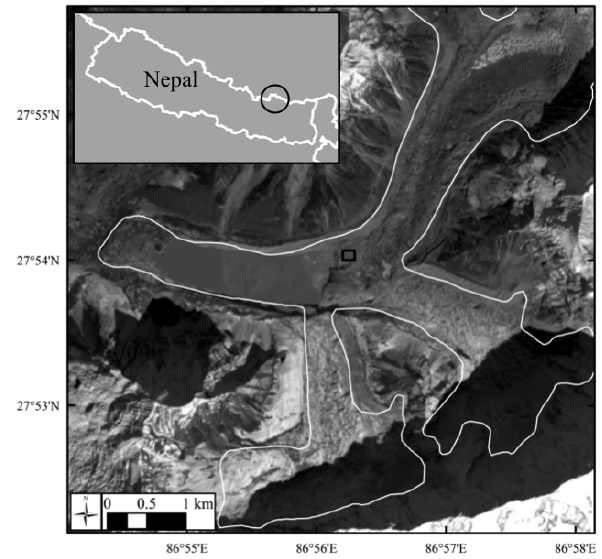
Figure 1. Landsat 8 panchromatic image from 14 November 2014 of Imja–Lhotse Shar Glacier with the focus area of this study high- lighted by the rectangular box several kilometers up-glacier from the terminus, and the site location within Nepal shown in the